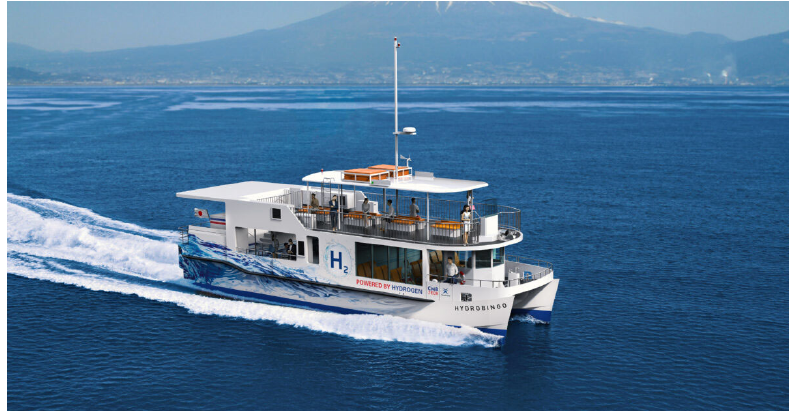
Figure 10. The HydroBingo vessel by CMB [81]. (Coypright CMB.TECH).